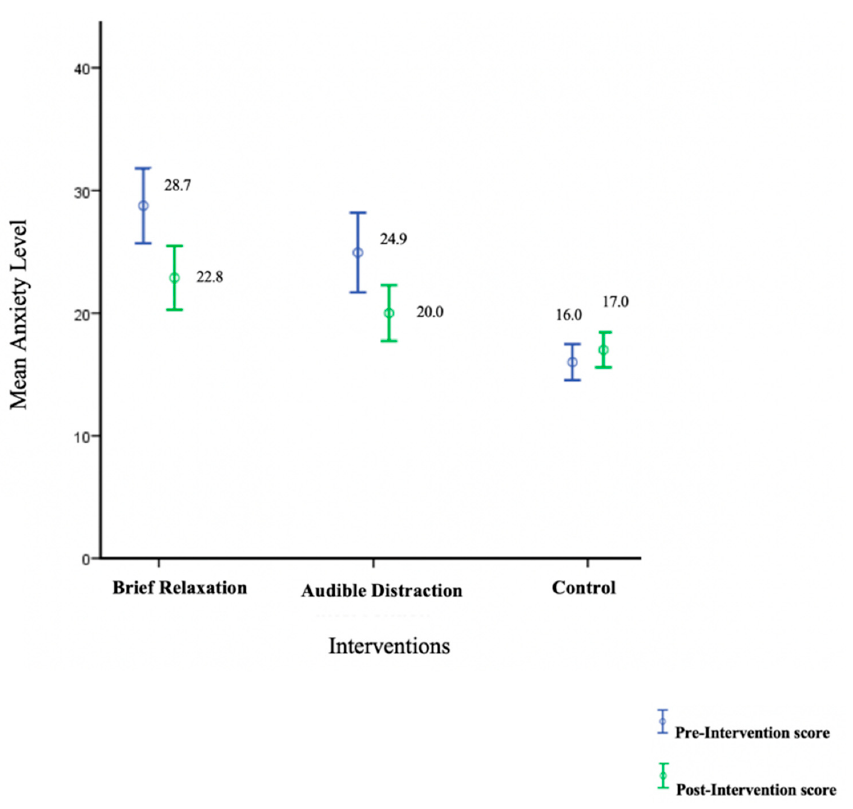
Figure 3. Graphical representation of the change in the mean anxiety scores before and after the interventions.